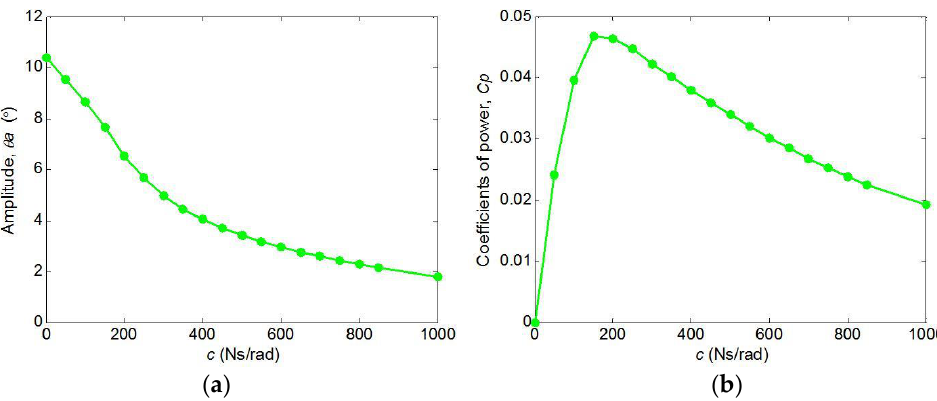
Figure 10. Effects of damping on ( a ) oscillation amplitude and ( b ) C p .